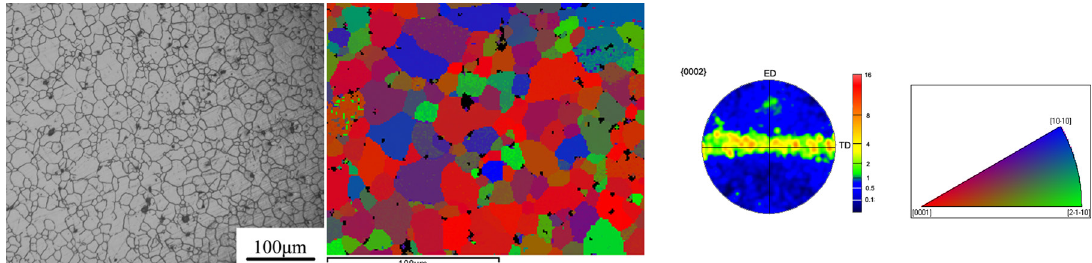
Figure 2. Microstructure and (0002) pole figure of as-extruded AZ31 magnesium alloy